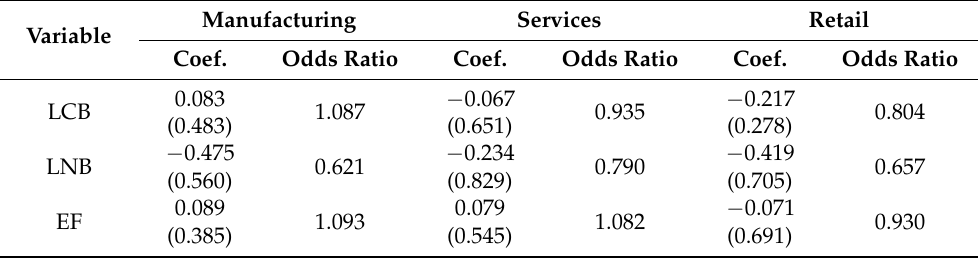
Table 8. Logit binary model’s estimation results *—supply